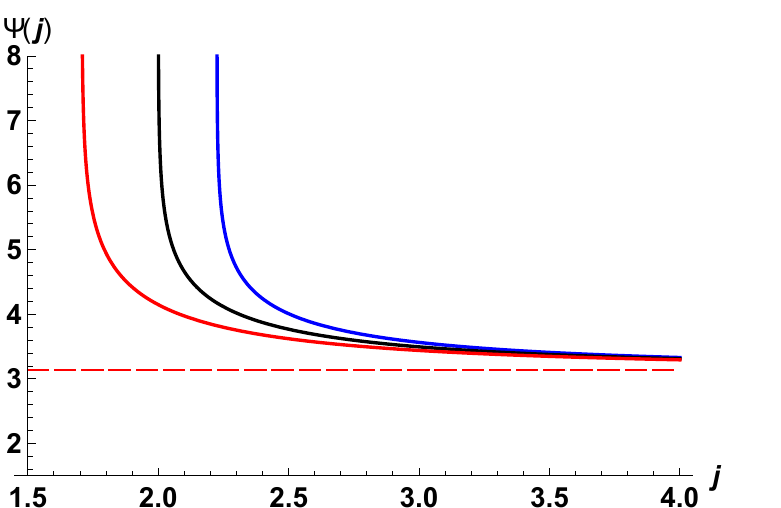
Figure 3. Periastron coordinate Ψ p ( j ) as a function of the moment j for black hole spin-values ω : blue for ω = 1/3, black for ω = 0, and red for ω = − 1/3.